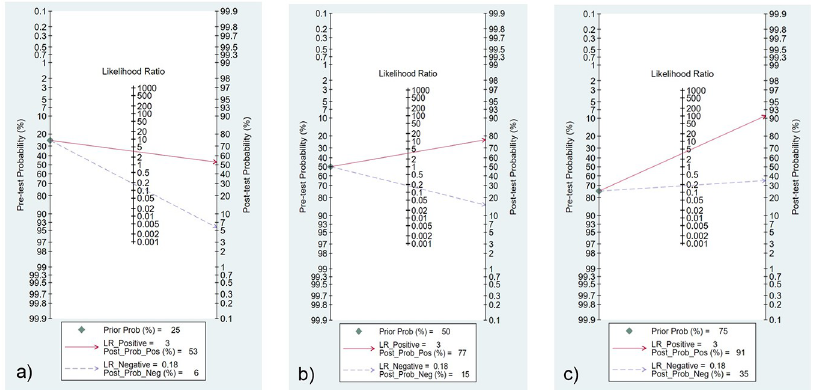
Fig 8. The Fagan diagram analysis results obtained in this paper: a)—c) pre inspection probability is 25%, 50% and 75%